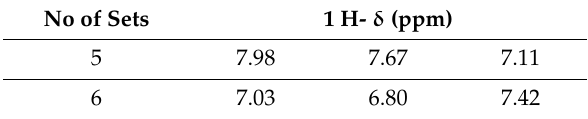
Table 2. Quinoline protons identified from total correlation spectroscopy (TOCSY) map.